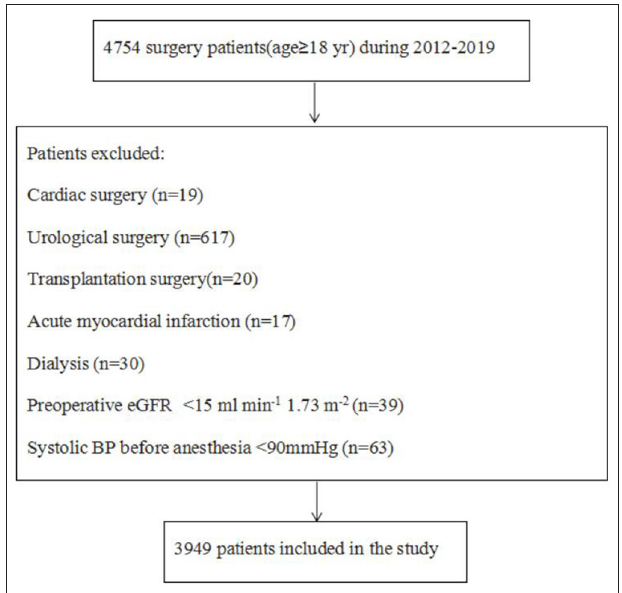
FIGURE 1 | Flow chart for patient